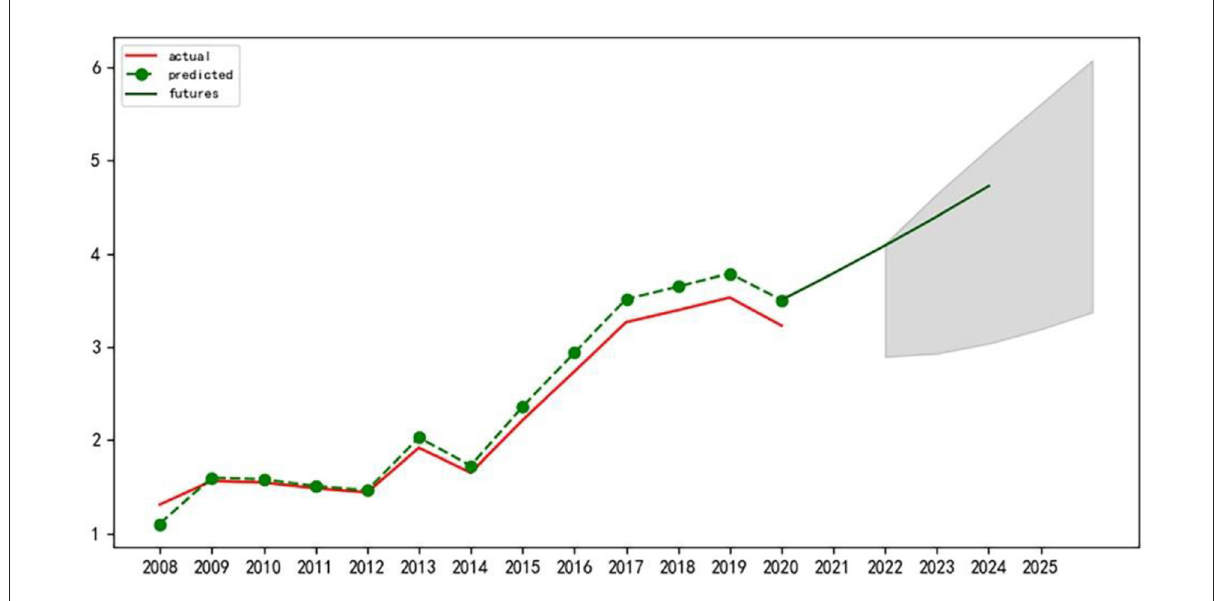
FIGURE4 Prediction of variable eigenvalues of sustainable development level of APSC in Heilongjiang